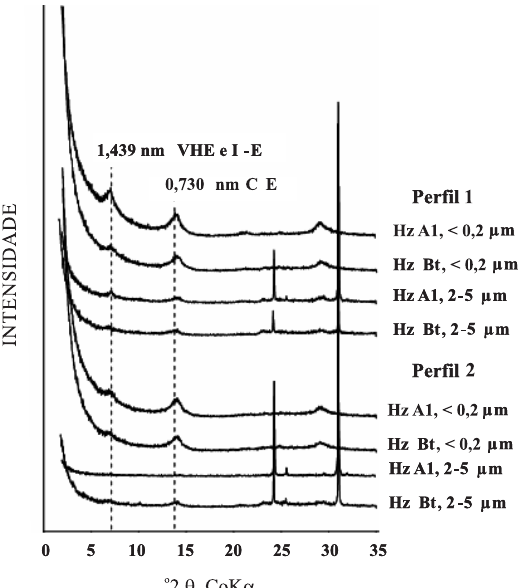
Figura 3. Difratogramas de raios X (25 °C) da fração menor que 0,2 (cid:122) m e entre 2-5 (cid:122) m, saturadas com e Bt de um Argissolo Ca 2+ dos horizontes A 1 Vermelho-Amarelo distrófico abrúptico, perfil 1, localizado em meia encosta sob campo nativo e perfil 2, em topo de coxilha sob vegetação